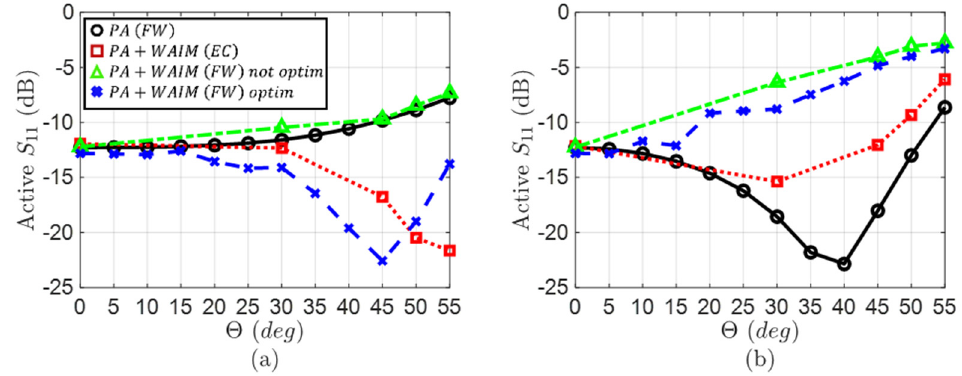
Figure 8. Active reflection coefficient at f = 18 GHz without limiting d WAIM : ( a ) H-plane and ( b ) E-plane ; phased array ( PA ), full-wave ( FW ).